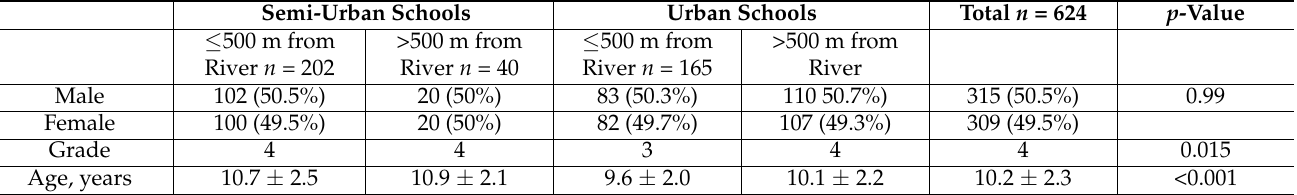
Table 1. Characteristics of study population by primary school location in Mekele,